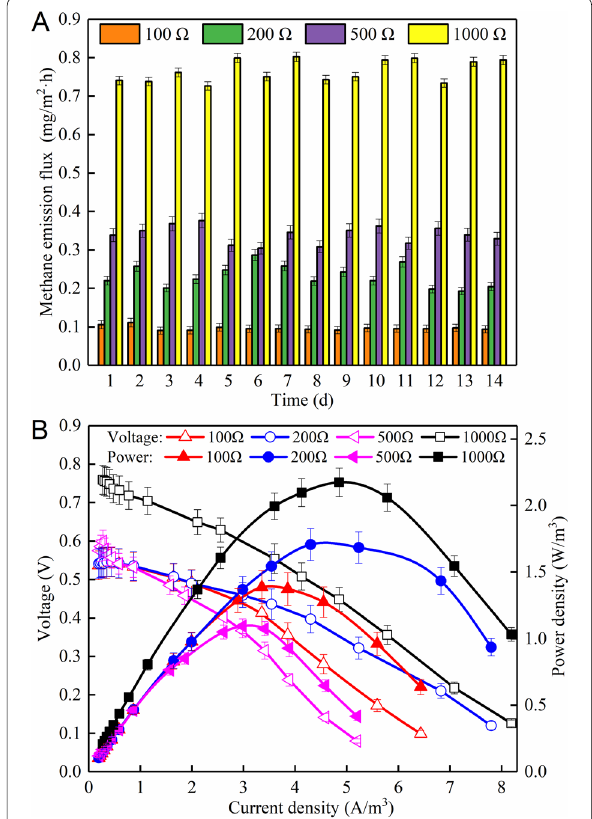
Fig. 3 ( A ) CH 4 emission fluxes and ( B ) polarization/power density curves of CW–MFCs with different external